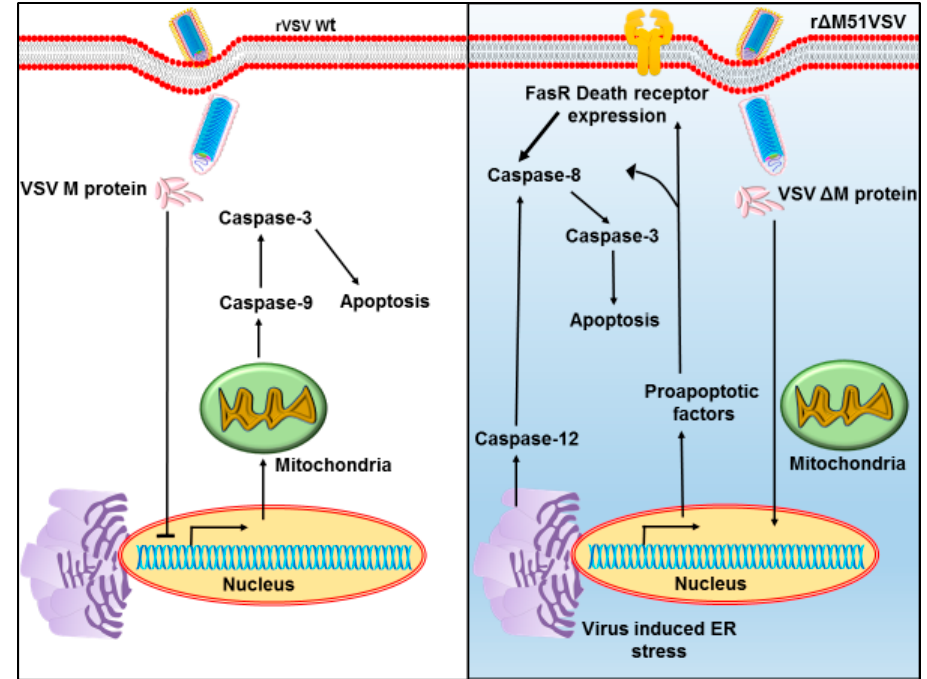
Figure 3. Modified matrix protein is a superior oncolytic agent. The left panel shows the action of wild-type matrix protein and pathways leading to cellular apoptosis. The right panel depicts mutant of matrix protein efficient in apoptosis in cancer cells. ER: endoplasmic reticulum; rVSVwt: recombinant VSV wild type; r Δ M51VSV: recombinant VSV with mutation at 51st position in its matrix protein.